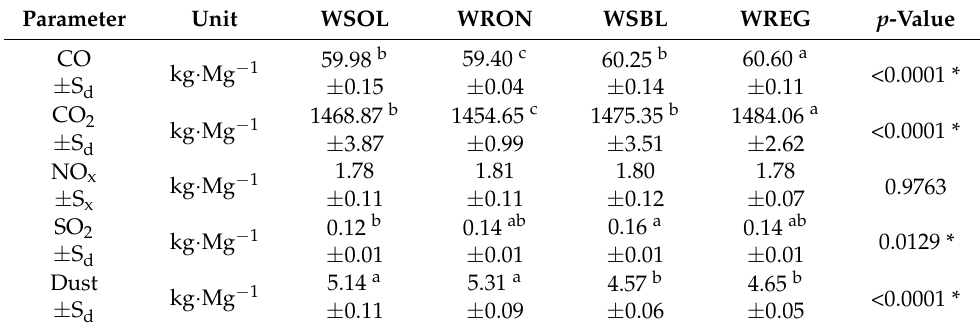
Table 5. Emission indexes for waste shoots of selected grapevine